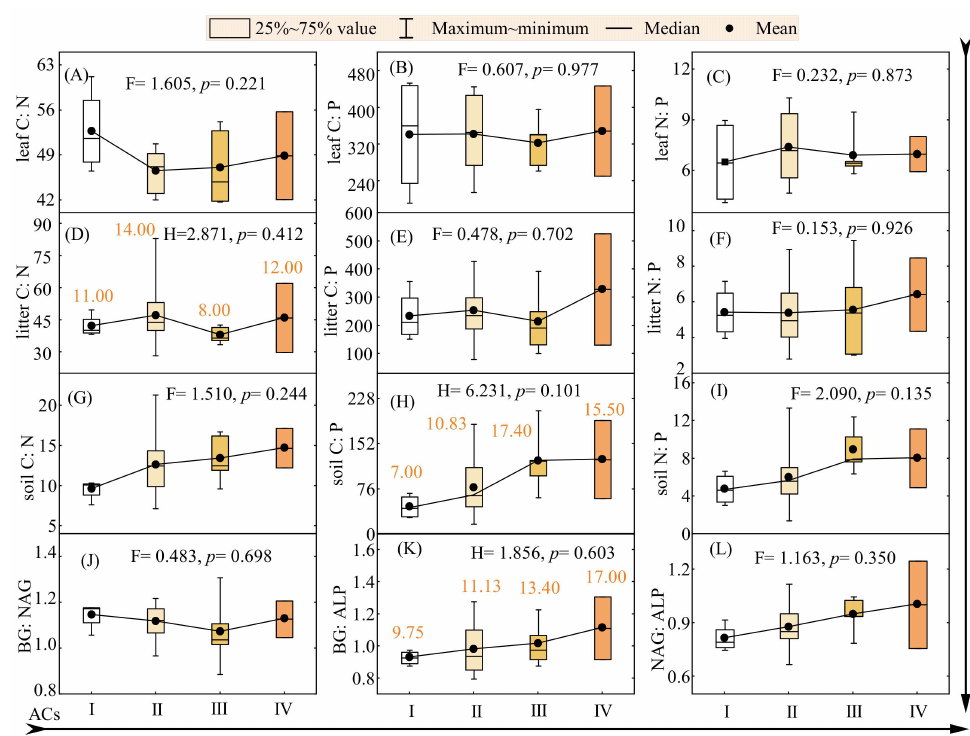
Figure 4. Ecological stoichiometric ratios (mass ratios) for plant leaf ( A – C ), litter ( D – F ), soil nutri-